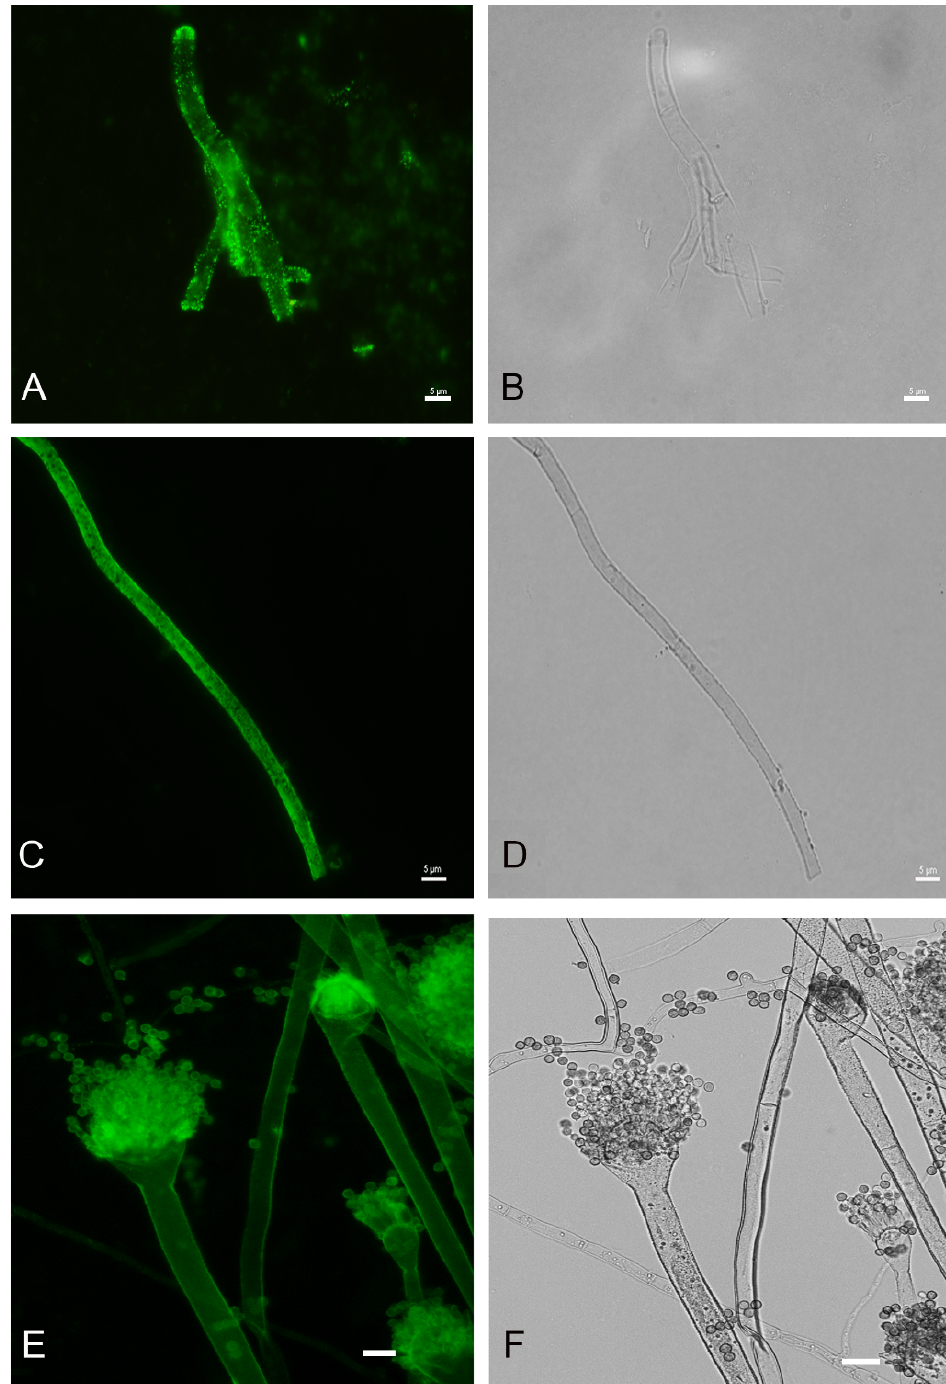
Figure 5. Melanin-specific MAb 8D6 labels the cell walls of septate hyphae of fungal keratitis caused by A. flavus . Corresponding immunofluorescence and bright-field microscopy images demonstrating the labelling with MAb 8D6 of the cell walls of hyphae in a corneal sample of FK ( A , B ), melanin extracted particles of hyphae recovered from the patient’s corneal material ( C , D ) and melanin expression in the associated A. flavus culture ( E , F ). Bars, 5 μ m.